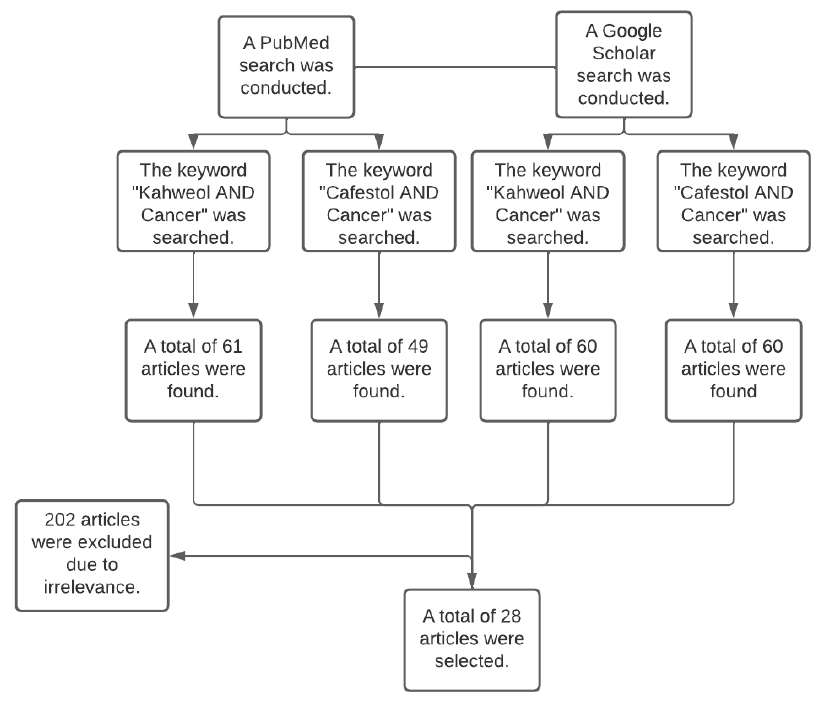
Figure 4. The flowchart represents the data collection process, including the used databases (PubMed and Google Scholar), the keywords, and the number of included and excluded articles.